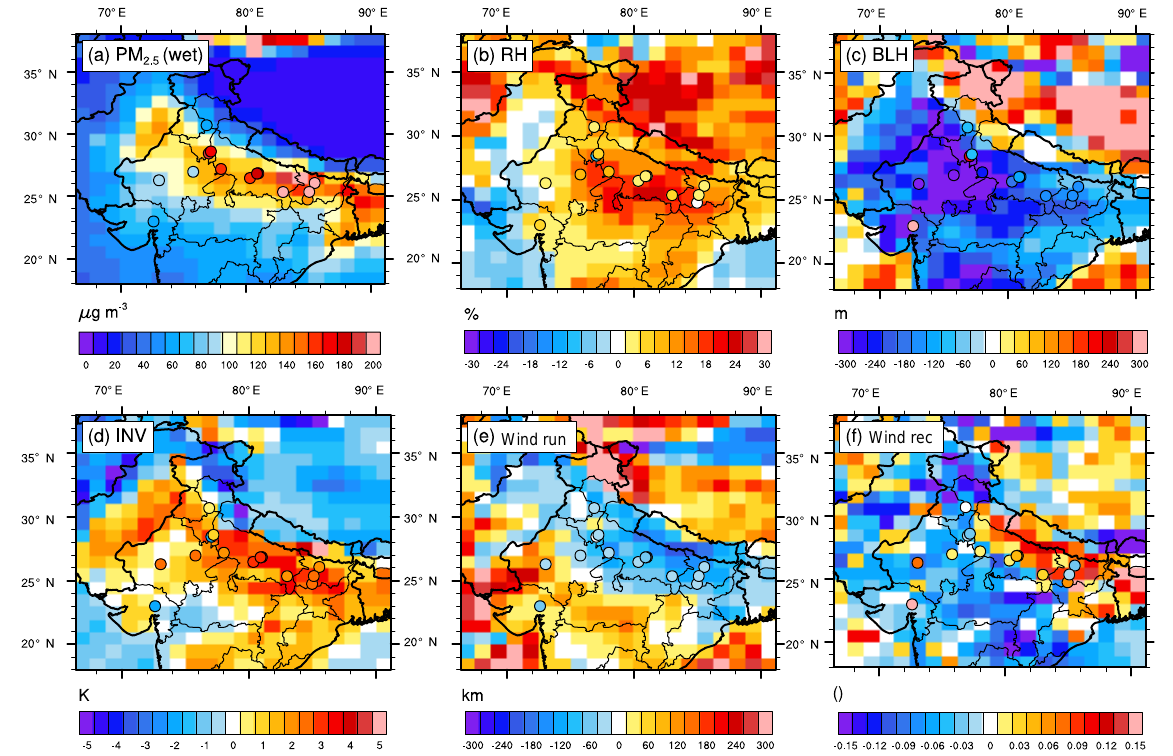
Figure 8. Composite of the 10 days with the highest PM 2 . 5 abundance minus the 10 days with the lowest from October 2015–March 2016 for daily averages of (a) PM 2 . 5 (wet, µgm − 3 ), (b) relative humidity (%), (c) boundary layer height (m), (d) temperature inversion strength (K), (e) wind run (km), and (f) wind recirculation (unitless) for the observations (circles) and the AM4-CMIP6-wet